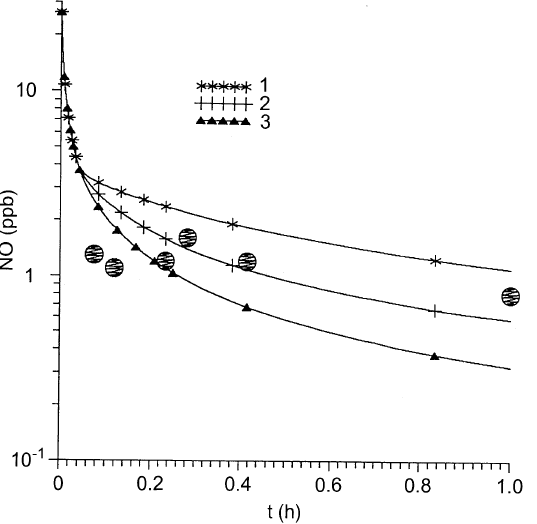
Fig. 3. Time evolution of the (NO) mixing ratio in the model box: (cid:49) , narrow plume; (cid:50) , basic, (cid:51) , wide plume, and circles , measured (NO) in cross section of various exhaust plumes over the eastern Atlantic (Schlager et al ., 1994)